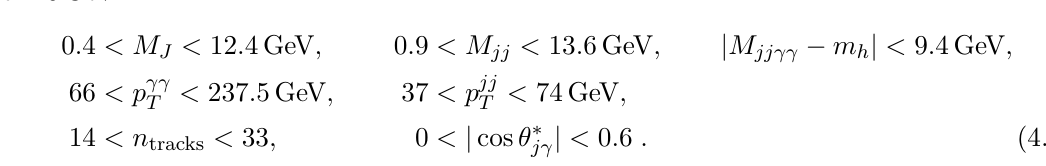
Figure 2 . The γ ( γ ) transverse momentum (upper left), j ( j ) transverse momentum (upper right), the number of tracks of the leading jet (lower left), and cos θ ∗ distributions for ALP masses of 1, 3, 30, and 50 GeV and for the j + γ and jj + γγ backgrounds. All distributions are normalized to